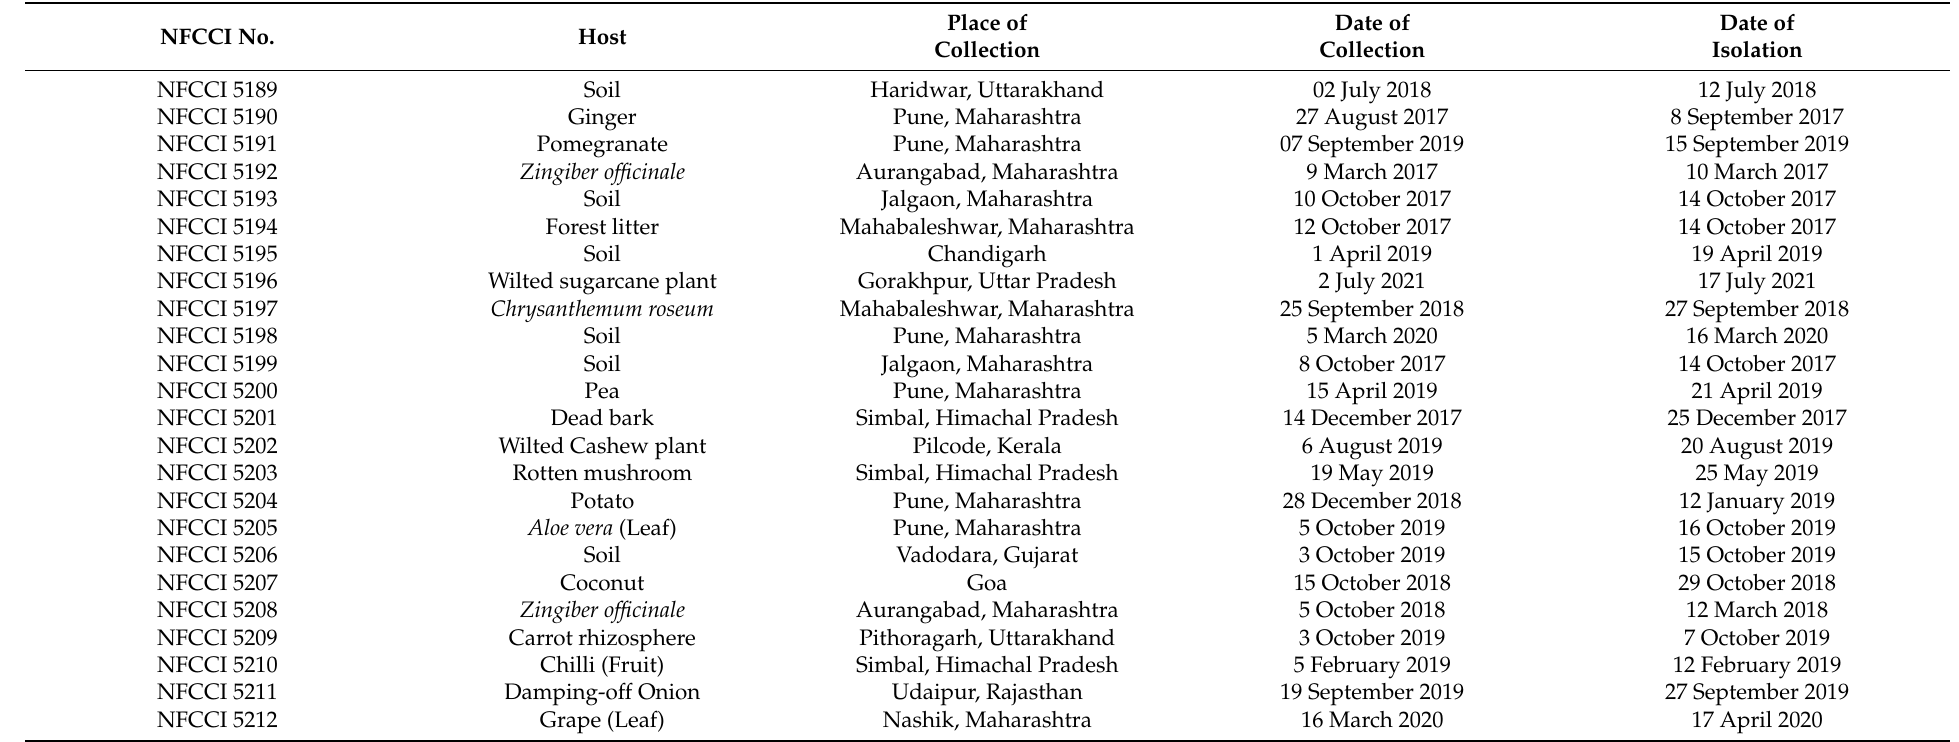
Table 2. Twenty-four isolates isolated in this study along with their accession nos., host, place of collection, date of collection and date of isolation details. NFCCI